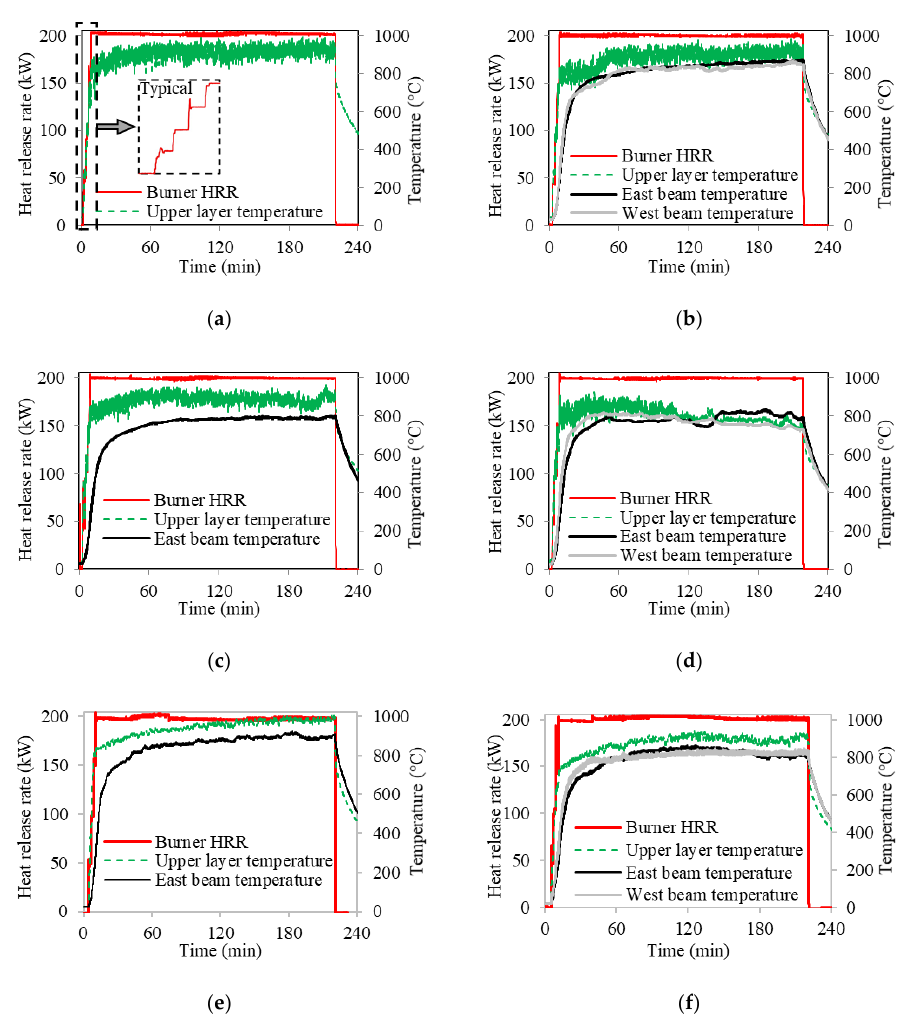
Figure 5. Heat release rate and temperature: ( a ) CS-1, ( b ) CS-2, ( c ) CS-3, ( d ) CS-4, ( e ) CS-5, and ( f ) CS–6.